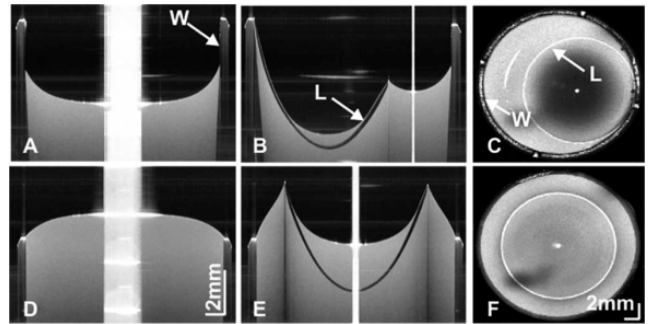
Figure 6. Experimental confirmation of the capillary forces between wet cell walls filled with a solution of increased reflectivity and a CL. Concave ( A ) and convex meniscus ( D ) formed at a partially-filled and overfilled cuvette as cross-sectional images. Cross-sections ( B,E ) and en face projections ( C,F ) showing attraction and repulsion effects (W, cuvette wall; L, contact lens). Adapted from Karnowski et al. [58].